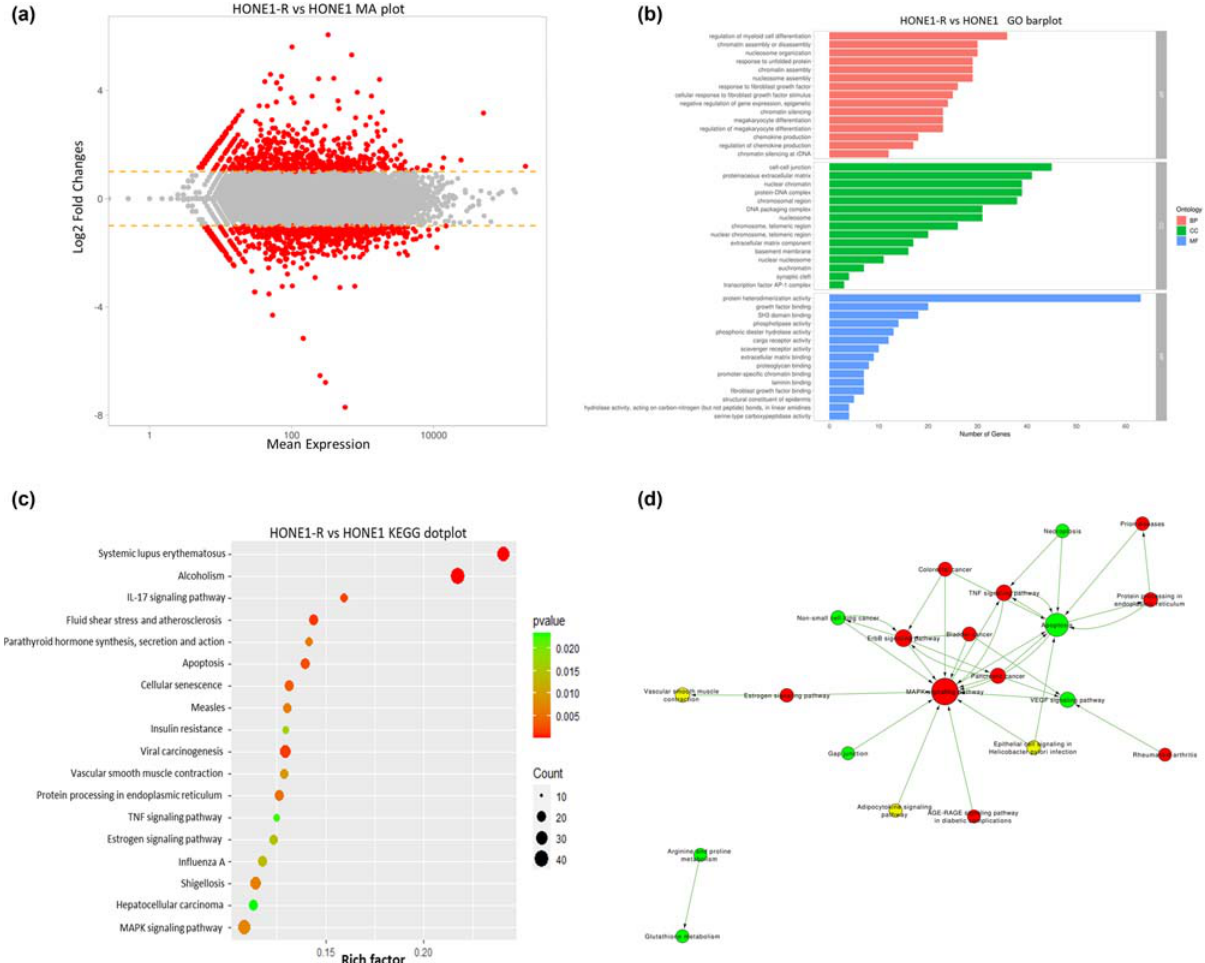
Figure 3: Data analysis of transcriptome sequencing: ( a ) MA plot of HONE1 and HONE1 - R cell lines; ( b ) GO analysis of di ff erently expressed genes; ( c ) KEGG signaling pathway analysis of di ff erently expressed genes; and ( d ) network of di ff erently expressed